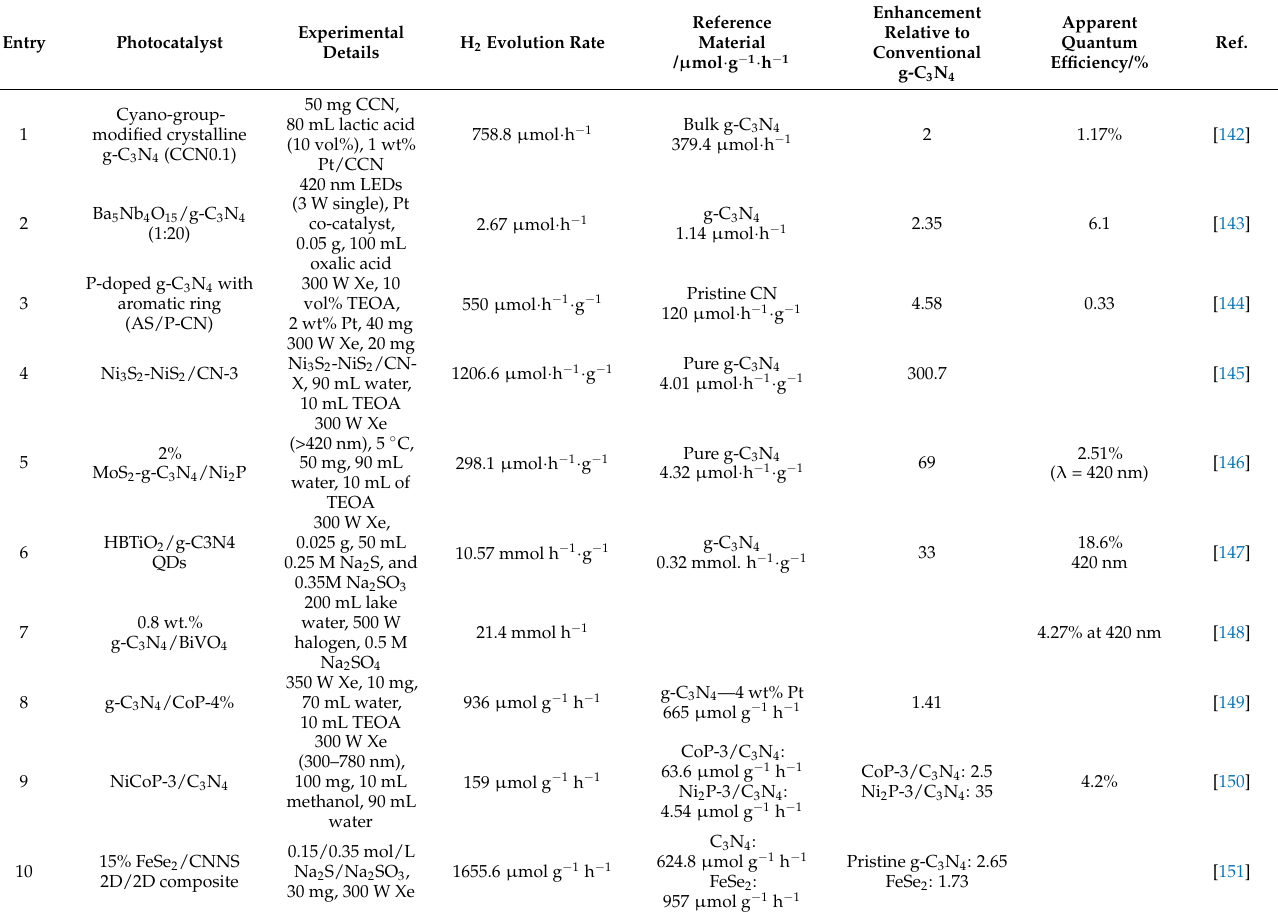
Figure 12. Schematic diagram for the performance comparison on hydrogen evolution between metal- and non-metal-modified g-C 3 N 4 composites. Reprinted with permission from Ref. [140]. Copyright 2023 Elsevier. Based on the descriptions mentioned above, Table 1 compares the performance of different g-C 3 N 4 -based materials for photocatalytic H 2 generation reported within the last three years. Table 1. Photocatalytic H 2 generation over g-C 3 N 4 -based materials.